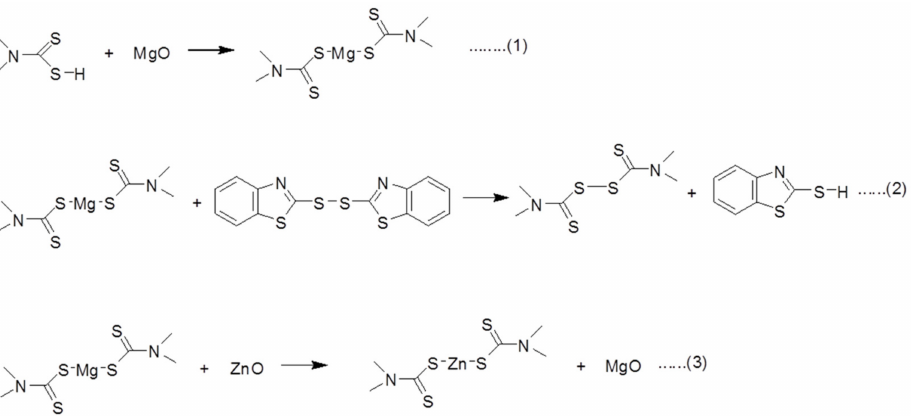
Figure 5. Possible chemical interactions between MgO and ZnO in the binary curing activators